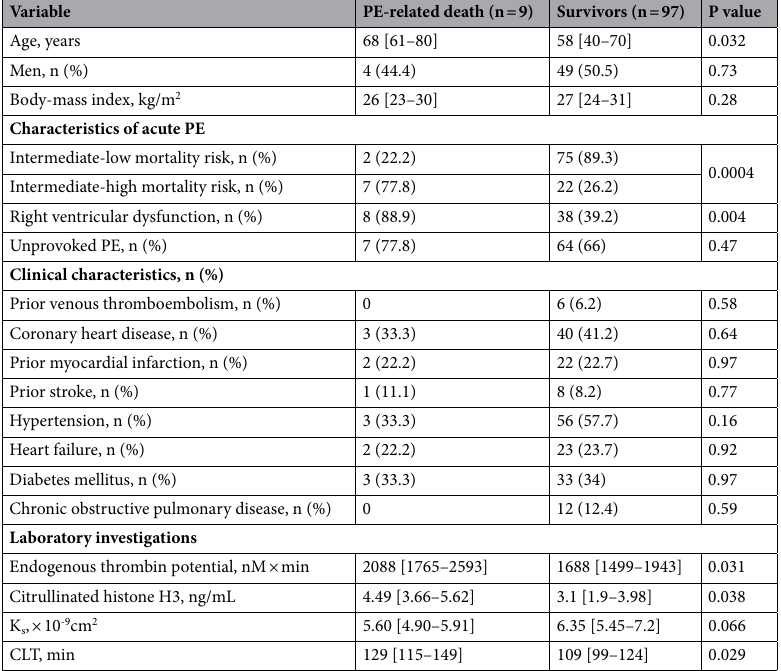
Table 2. Characteristics of acute PE patients with intermediate early mortality risk who died and survivors at 1-year follow-up. Data are shown as numbers (%) or median [1st quartile-3rd quartile]. K s fibrin clot permeability, CLT clot lysis time.